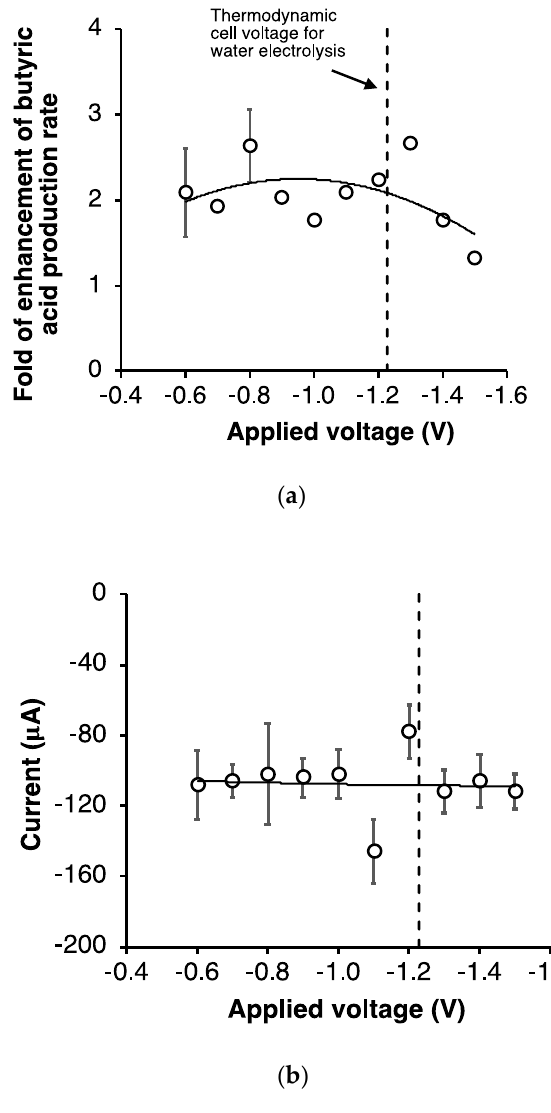
Figure 4. Effect of the applied voltage on ( a ) the fold of enhancement of butyric acid production rate relative to the OCP control (error bars represent the standard error of replicated experiments) and on ( b ) average electric current consumption (standard errors refer to mean values). Experimental data fitted with a 2nd order polynomial curve.